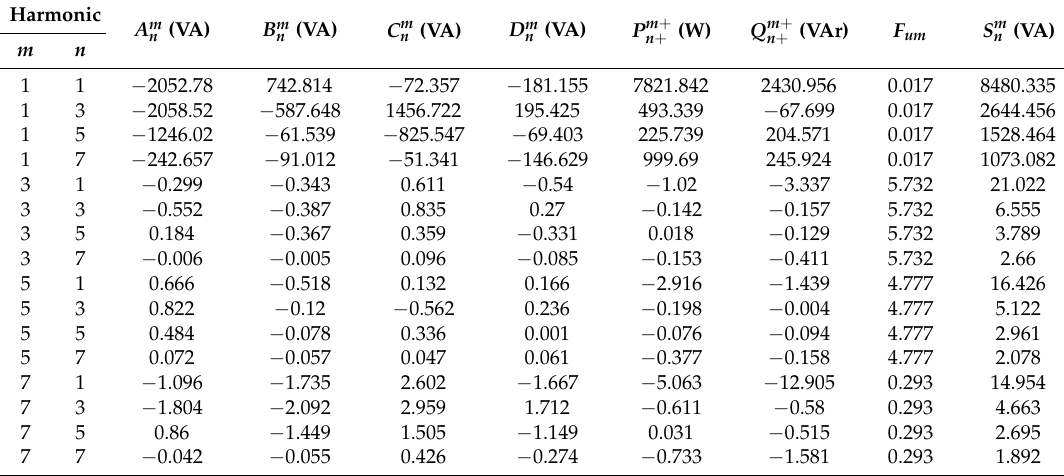
Table 6. Results in Bus